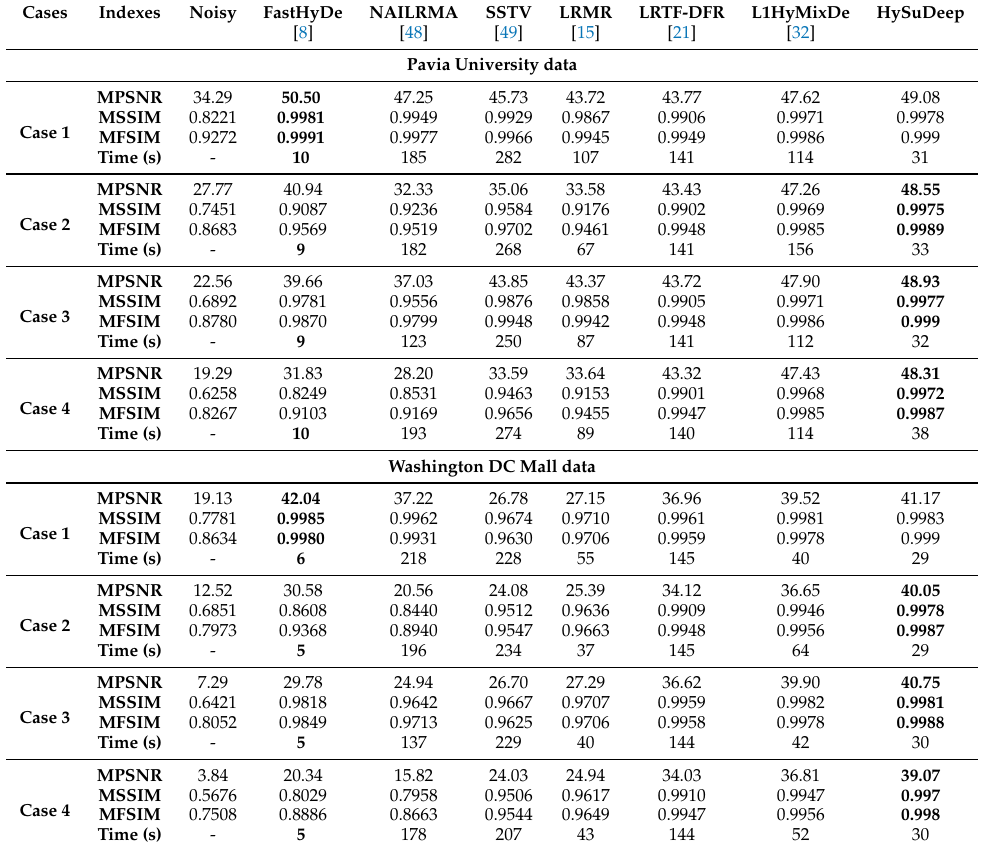
Table 2. Performance of the proposed and comparison methods on Pavia University Data and Washington DC Mall Data.